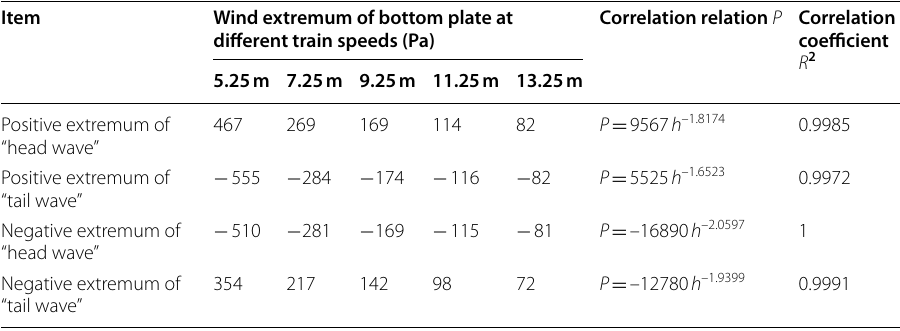
Table 2 Positive extremum and negative extremum of “head wave” and “tail wave” of bottom plate for different clearances